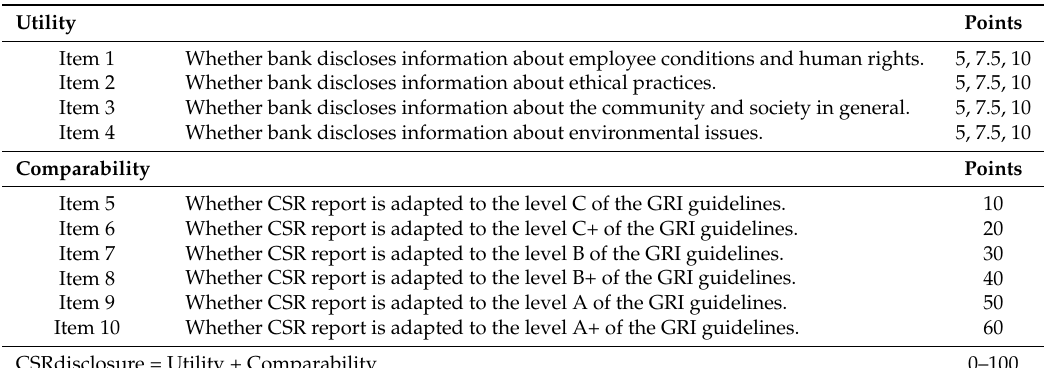
Table 2. Scoring criterion for dependent